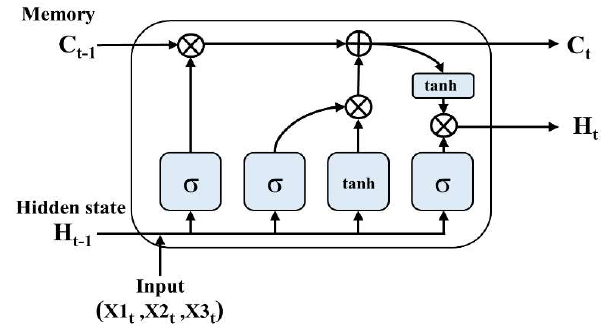
Figure 5. Structure of employed LSTM (X1: lead1 ECG data, X2: lead2 ECG data, X3: lead3 ECG data). LSTM: long short-term memory